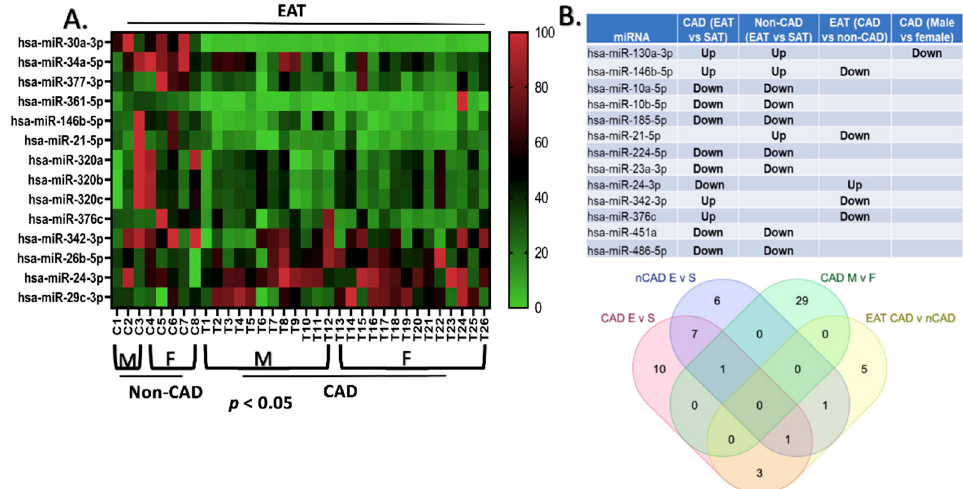
Figure 2. Heatmap of differentially expressed miRNAs in EAT between CAD and non-CAD: mi- croRNA microarray on EAT from patients with and without CAD (both males and females) were compared. Fourteen microRNAs were significantly altered (expression data points for each miRNA were normalized on a 0–100 scale with 0 (green), being the lowest expression and 100 (red) being the greatest). hsa-miR-29c-3p, hsa-miR-24-3p, and hsa-26b-5p were upregulated in the EAT of patients with CAD ( A ). List of microRNAs that were similarly altered in EAT vs. SAT in patients with or without CAD and their sex specificity is displayed in the table and lotus matrix ( B ). Only miRNAs with expressions that were found to be significantly different ( p < 0.05) in unpaired t -test are presented. The following groups of comparisons were included: CAD (EAT vs. SAT) = epicardial adipose tissue (EAT or E) versus subcutaneous adipose tissue (SAT or S) in patients with CAD (‘up’ indicates greater and ‘down’ indicates lower expression in EAT); nCAD (EAT vs. SAT) = epicardial adipose tissue versus subcutaneous adipose tissue in patients without CAD (‘up’ indicates greater and ‘down’ indicates lower expression in EAT); EAT (CAD vs. nCAD) = epicardial adipose tissue from patients with CAD versus epicardial adipose tissue from patients without CAD (‘up’ indicates greater and ‘down’ indicates lower expression in EAT of patients with CAD); CAD (male vs. female) = males versus females in patients with CAD (‘up’ indicates greater and ‘down’ indicates lower expression in females).